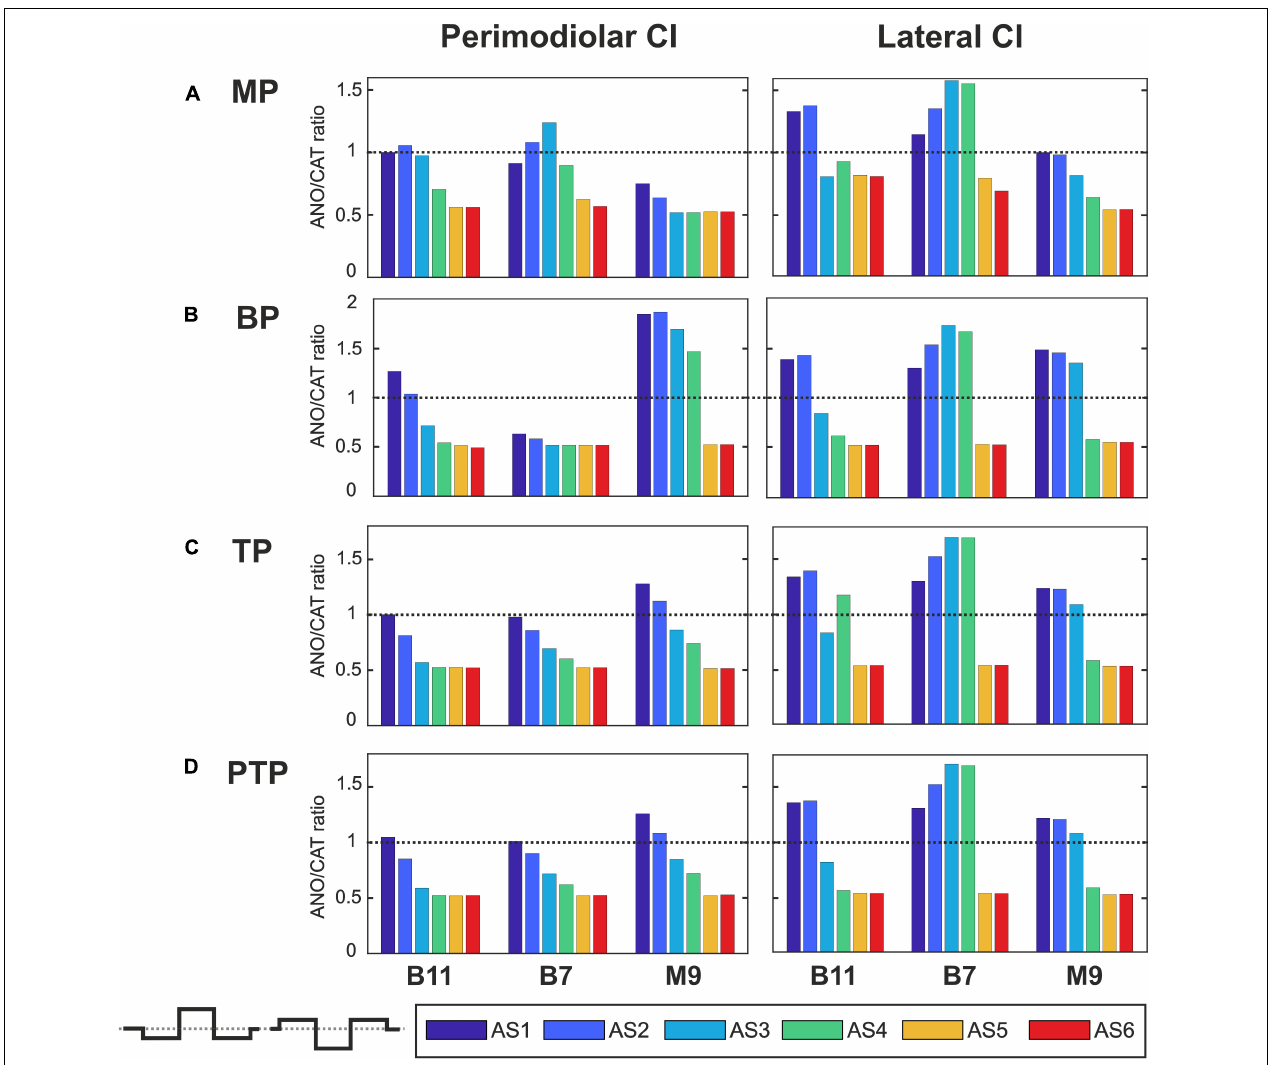
FIGURE 9 | Polarity ratios for different degeneration levels stimulated with the triphasic pulse. Layout as in Figure 7 .